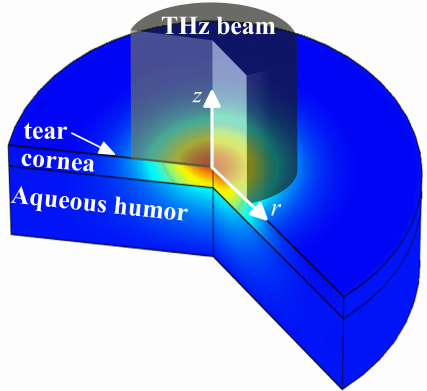
Figure 1. Schematic diagram of THz thermal treatment of the cornea (out of